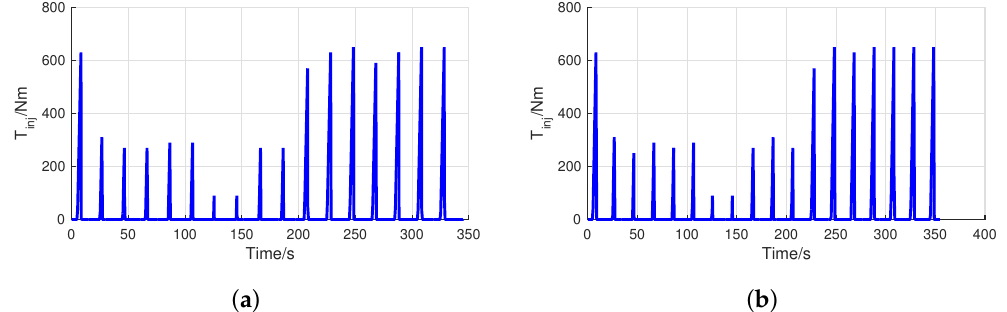
Figure 27. Injected drive torques: ( a ) Controller A + ISPFCE and ( b ) Controller B +